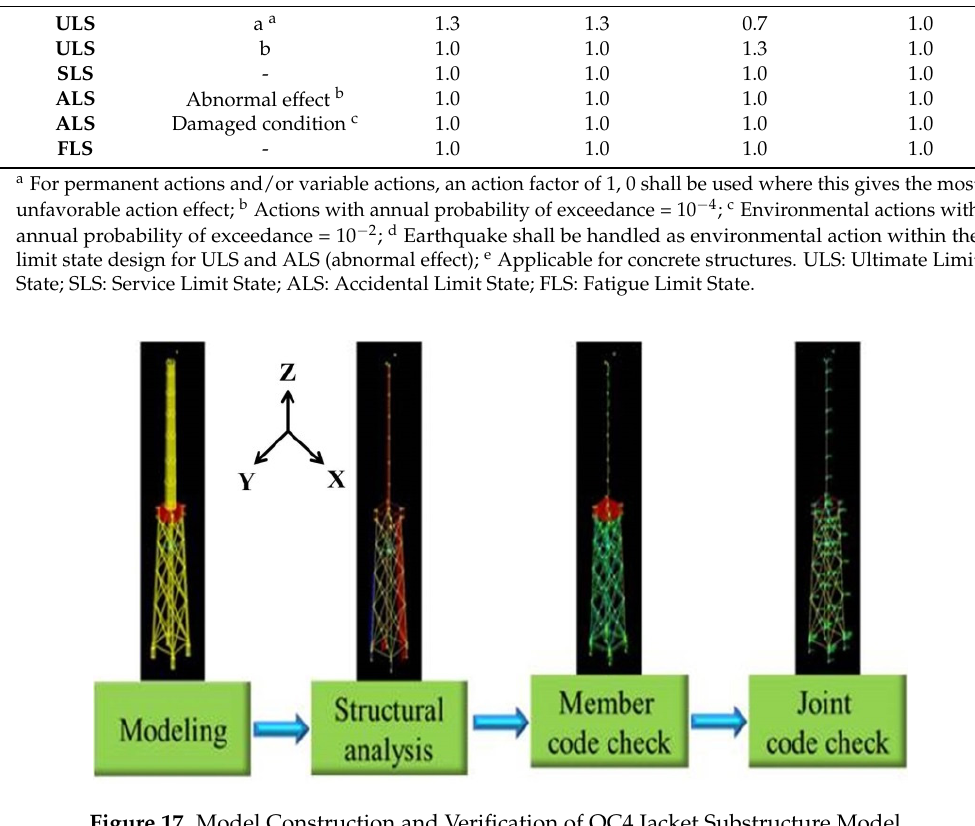
Table 12. Load and Resistance Factors of Load and Resistance Factor Design (LRFD).